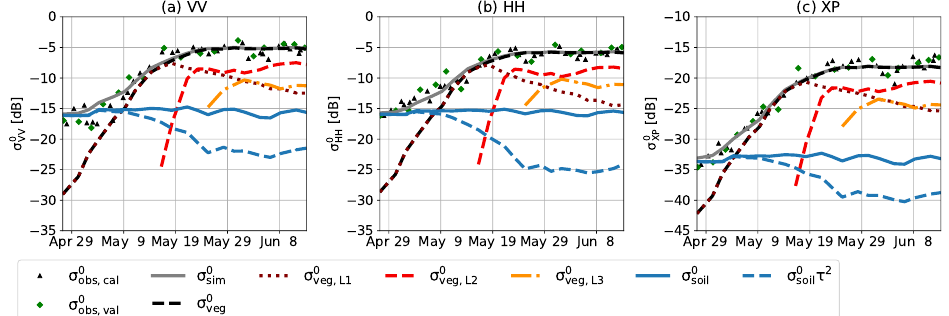
Figure 7. Seasonal variations in the contributions of the three different vegetation layers to total vegetation scattering ( σ 0 veg ), simulated by the 3-layer water cloud model. The different polarizations are separated in: ( a ) VV; ( b ) HH; and ( c ) XP.